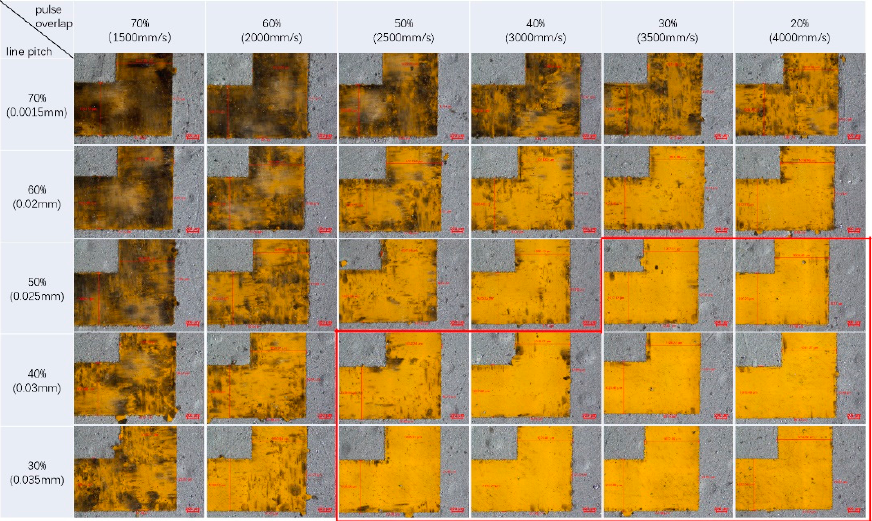
Figure 10. The etching results with different pulse overlaps by using a 32- μ m focal spot size. The areas looped with red lines showed better etching results.